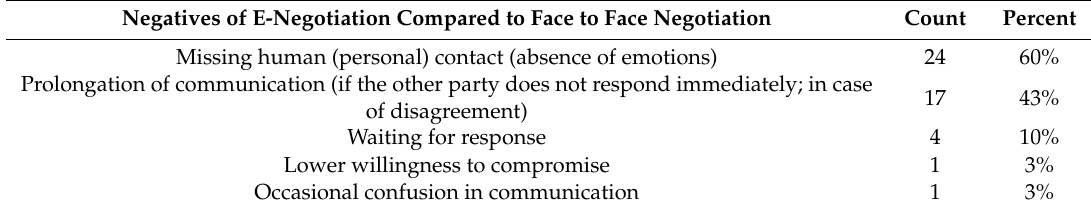
Table 2. Negatives of